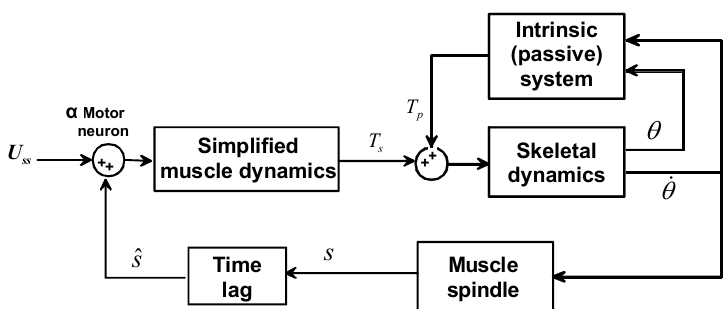
Fig.2. Block diagram of the neuromusculoskeletal system model.